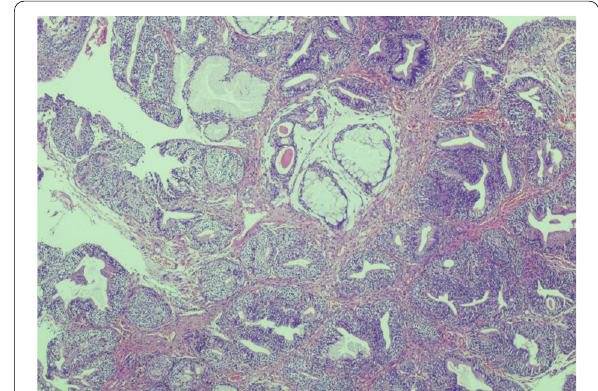
Fig. 2 Bladder mucosa exhibiting downward growing papillary architecture lined with transitional epithelium, representing a hamartoma of the urinary bladder. (H&E Stain, 20